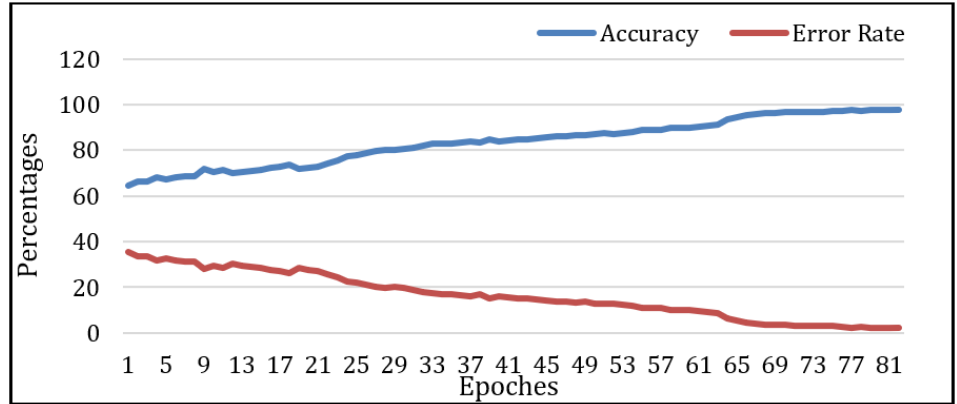
Figure 8. Training accuracy progression of the proposed model over the course of epochs.